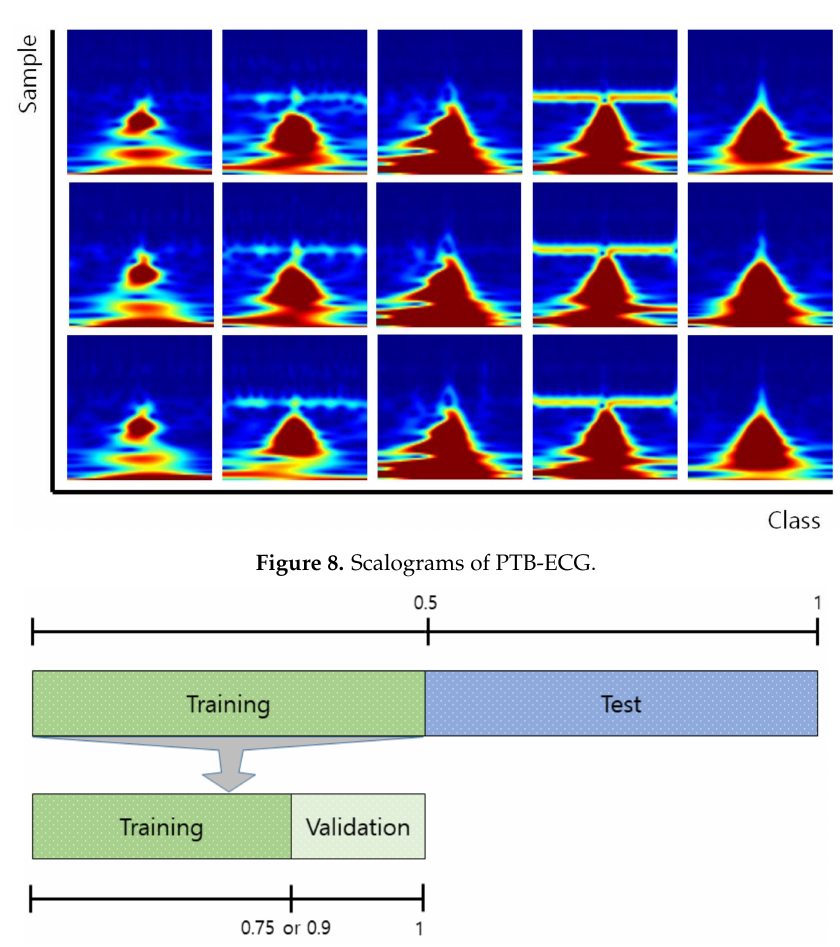
Figure 9. Data of training, validation, and test. Table 1. Performance of simple CNN (convolutional neural network) on